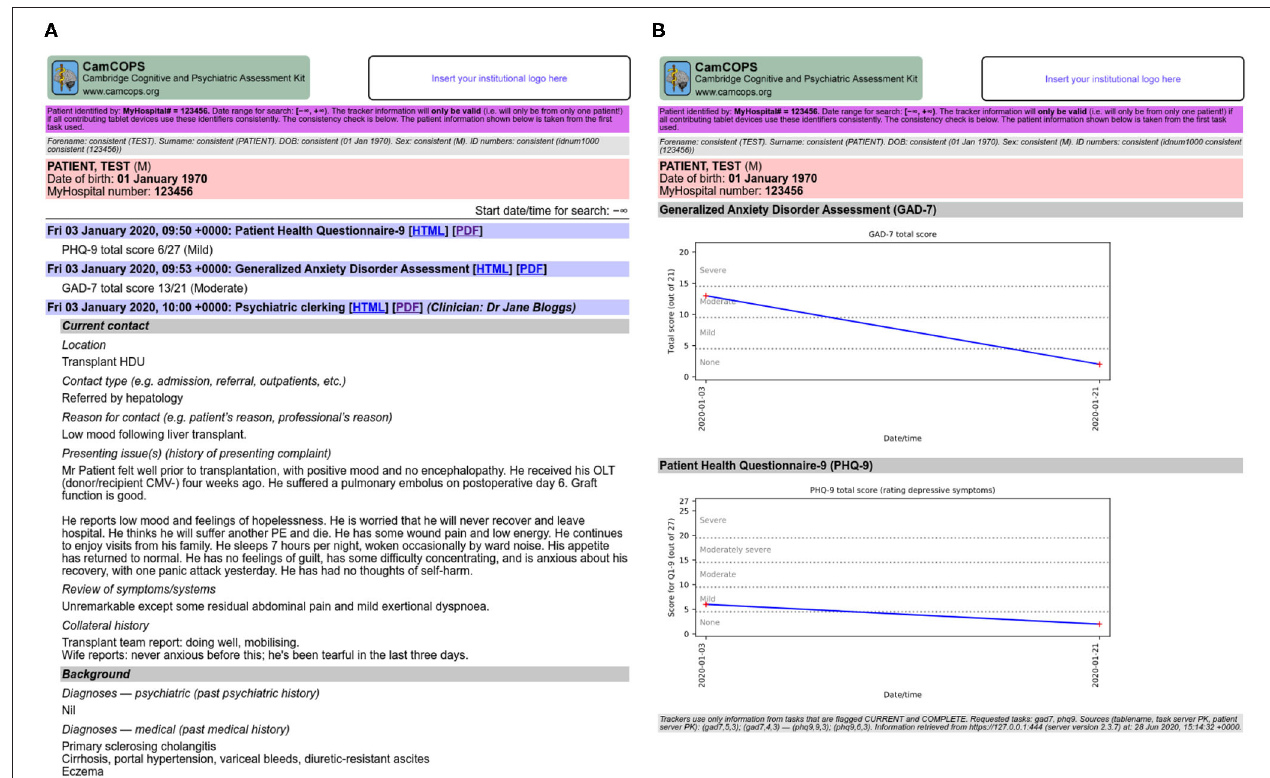
FIGURE 4 | Some multi-task views provided by the server. (A) Clinical text view. (B) Numerical tracker view. All data are fictional. CMV, cytomegalovirus; HDU, high dependency unit; OLT, orthotopic liver transplant; PE, pulmonary